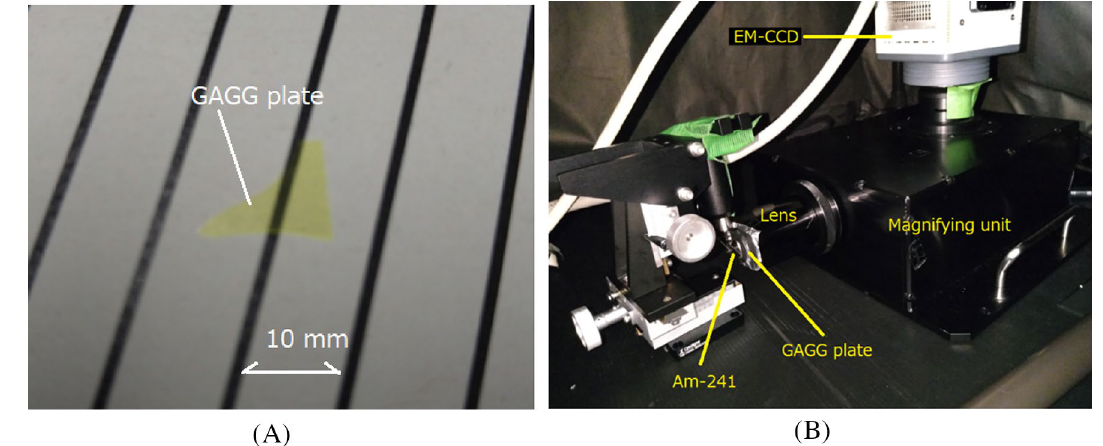
Figure 2. Photos of GAGG plate ( A ) and developed alpha-particle imaging system ( B